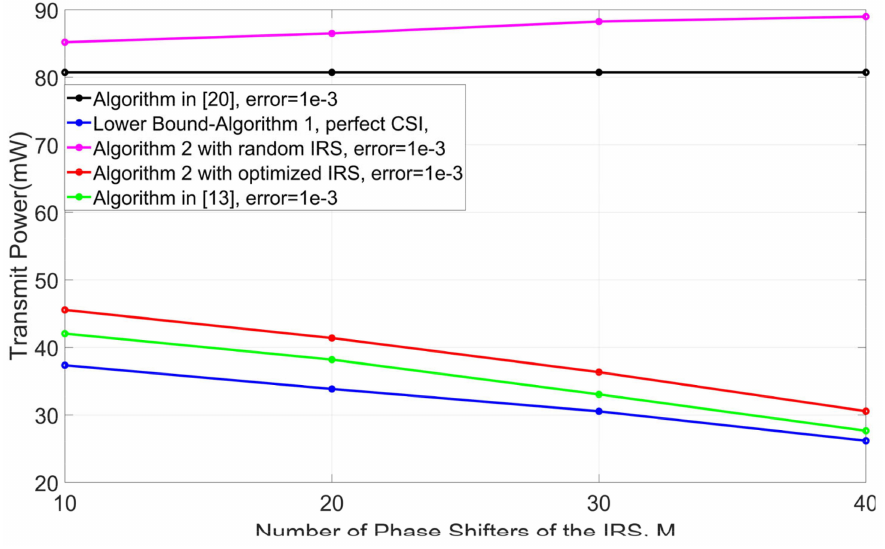
Figure 6. Effectiveness of the proposed algorithm under different numbers of the phase